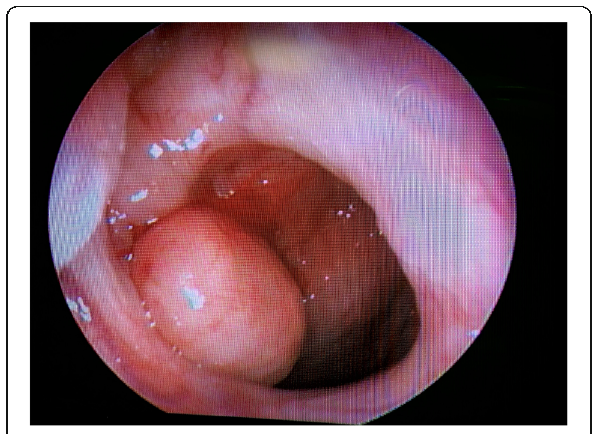
Fig. 1 A smooth globular mass of about 2 cm × 1 cm side occupying the right side of the nasopharynx obstructing the eustachian tube